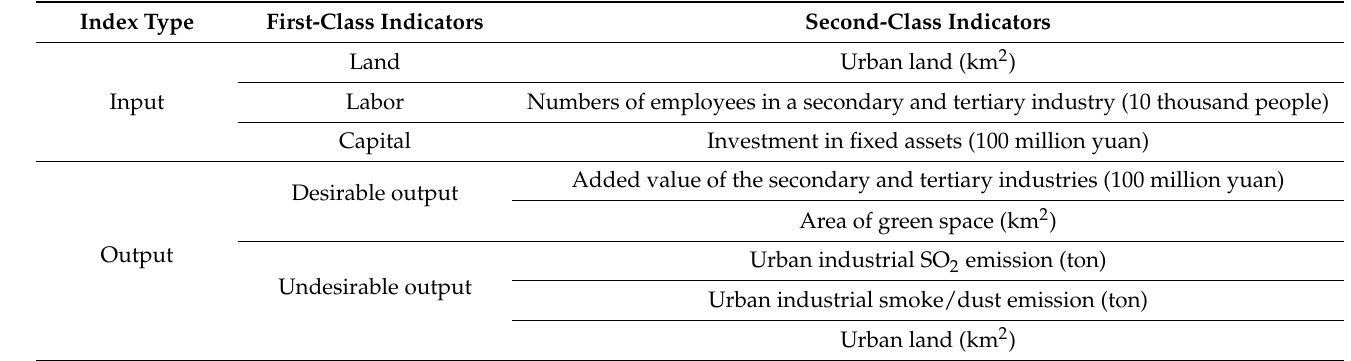
Table 1. Input—output indicators for measuring